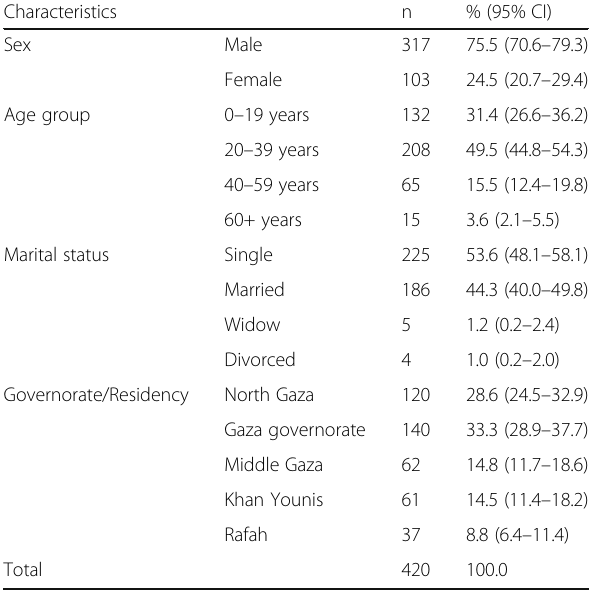
Table 1 Characteristics of war-injured persons ( n = 420)